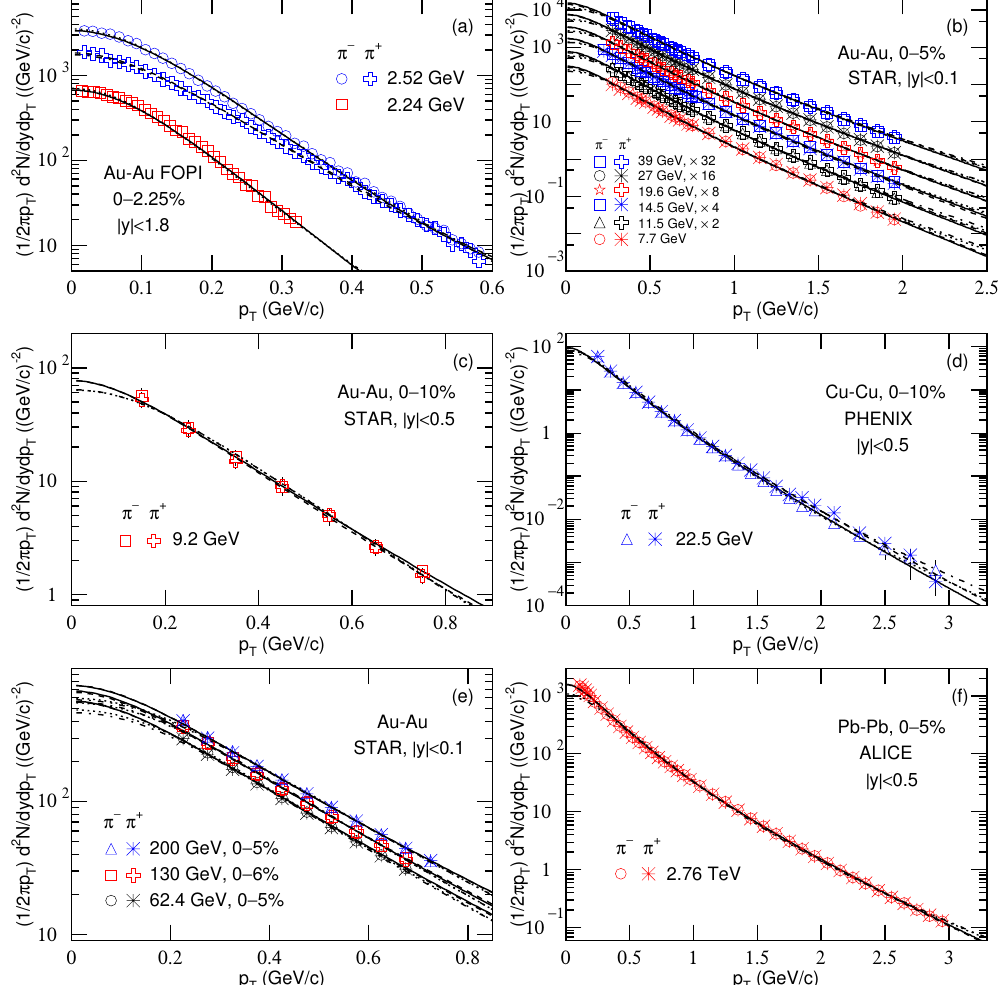
Figure A1. Same as Figure 1, but showing the results from central AA collisions. Panels ( a – f ) represent the data by various symbols measured by the FOPI [81], STAR [55], STAR [7], PHENIX [82], STAR [6], and ALICE [20] Collaborations,